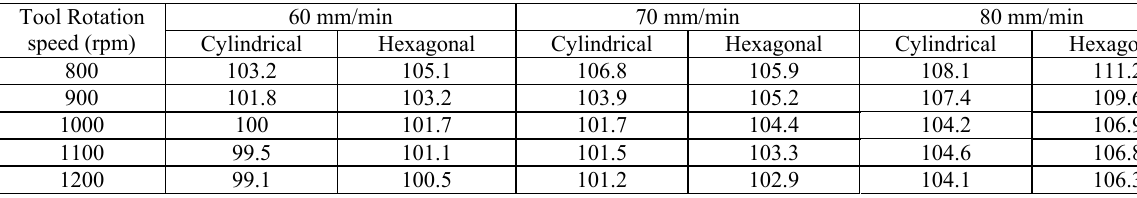
Table 6. Yield strength of the joint (in MPa) Tool Rotation